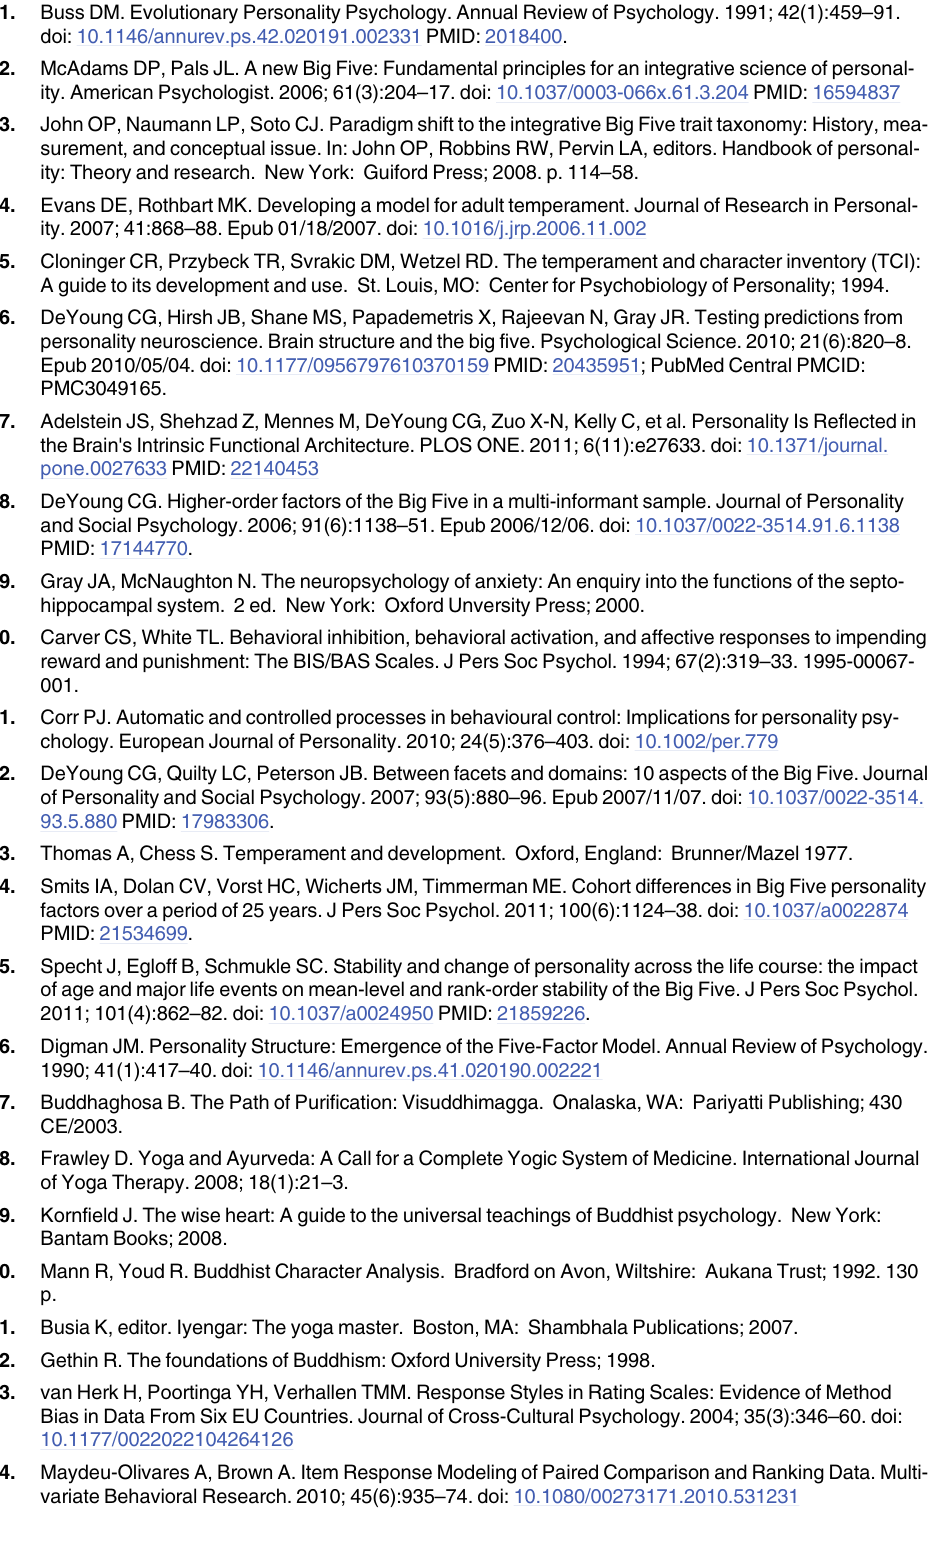
24. Maydeu-Olivares A, Brown A. Item Response Modeling of Paired Comparison and Ranking Data. Multi- variate Behavioral Research. 2010; 45(6):935 – 74. doi: 10.1080/00273171.2010.531231